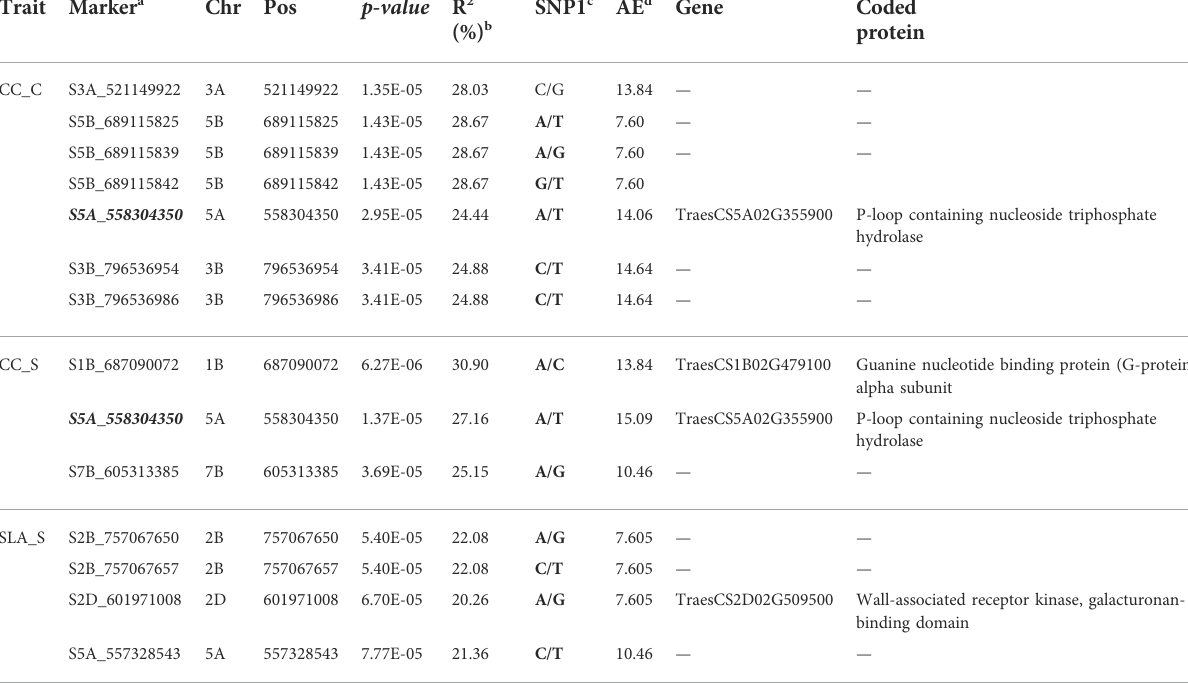
TABLE 2 Genome-wide association analysis for chlorophyll content (CC) and speci fi c leaf area (SLA) scored under control (C) and salinity (S) conditions. Trait Marker